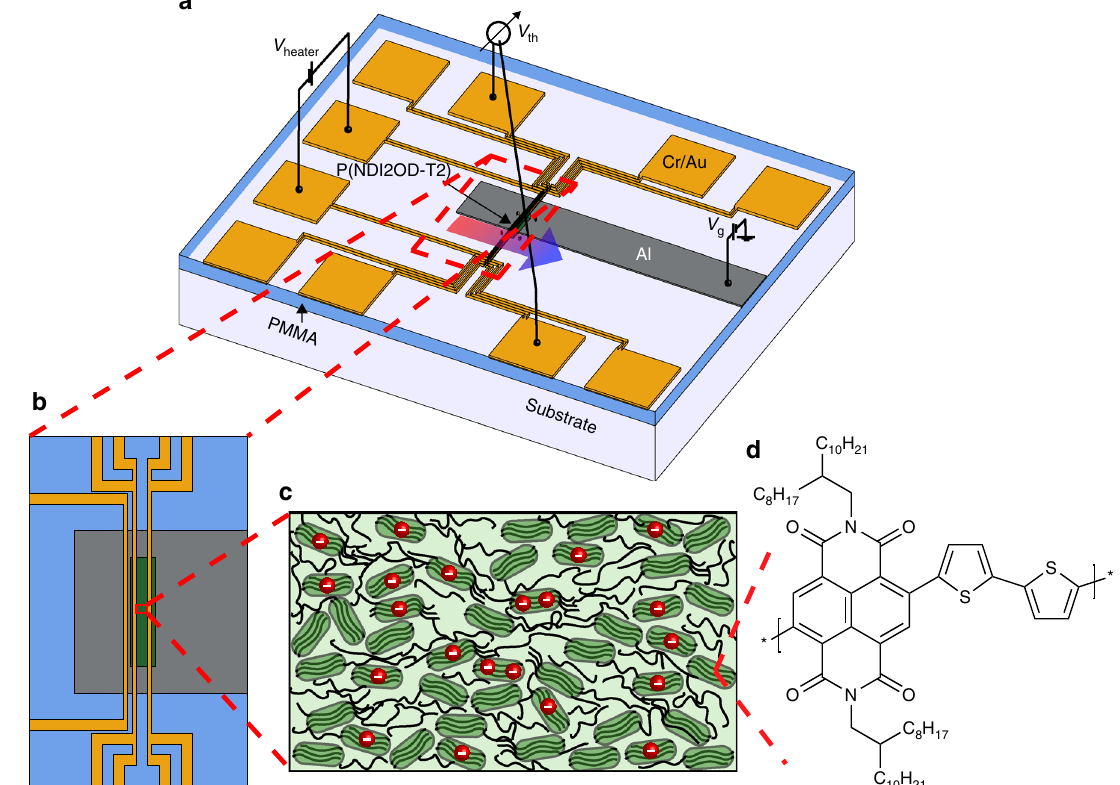
Fig. 1 Device architecture and model illustrations. Schematic of the device structure of the thin fi lm transistors with an on-chip heater element ( a , b modi fi ed dimensions for illustration) as well as the microstructure of the semicrystalline polymer semiconductors ( c ) and the structural formula of P (NDI2OD-T2) ( d ) are